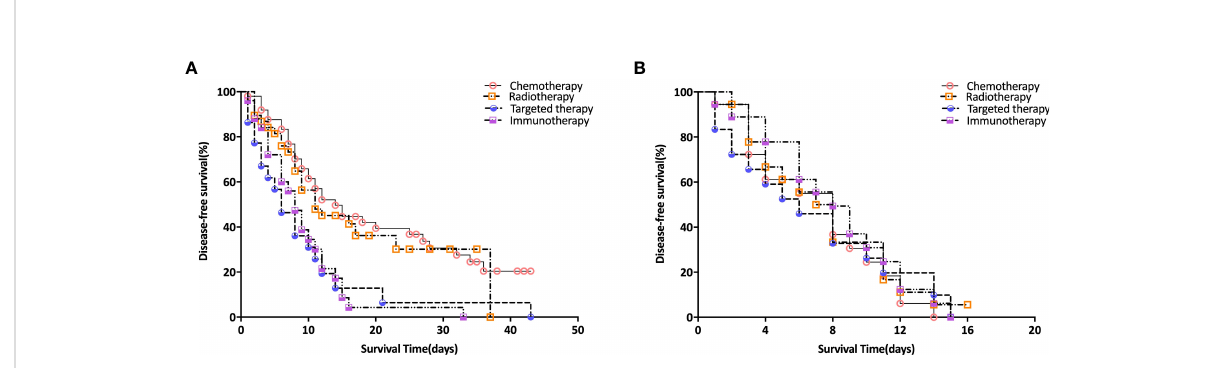
FIGURE 1 Survival Analysis of Patients with different treatments. (A) survival curves before PSM analysis; (B) survival curves after PSM